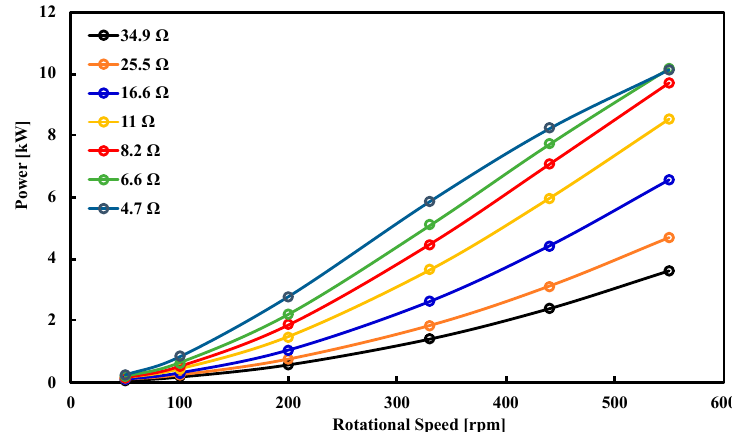
Figure 16. Drag force at different rotational speed.